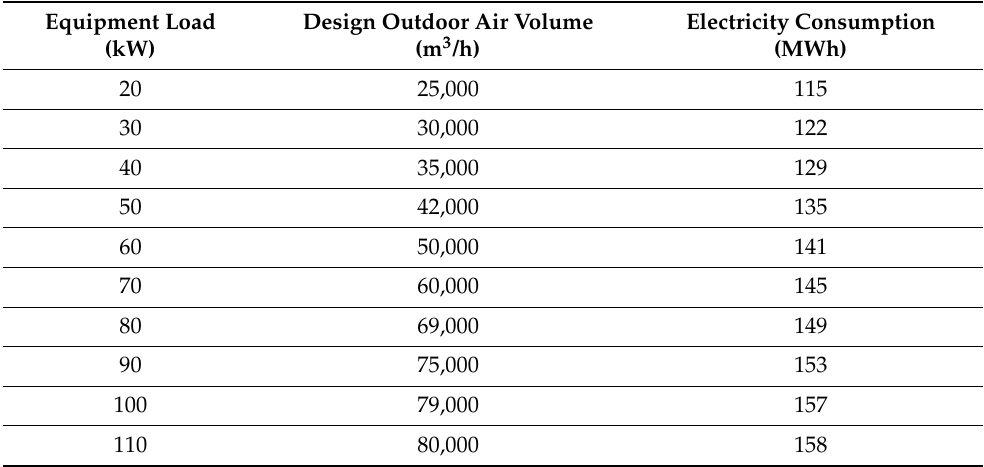
Table 6. Electricity consumption according to the design outdoor air volume by equipment load.